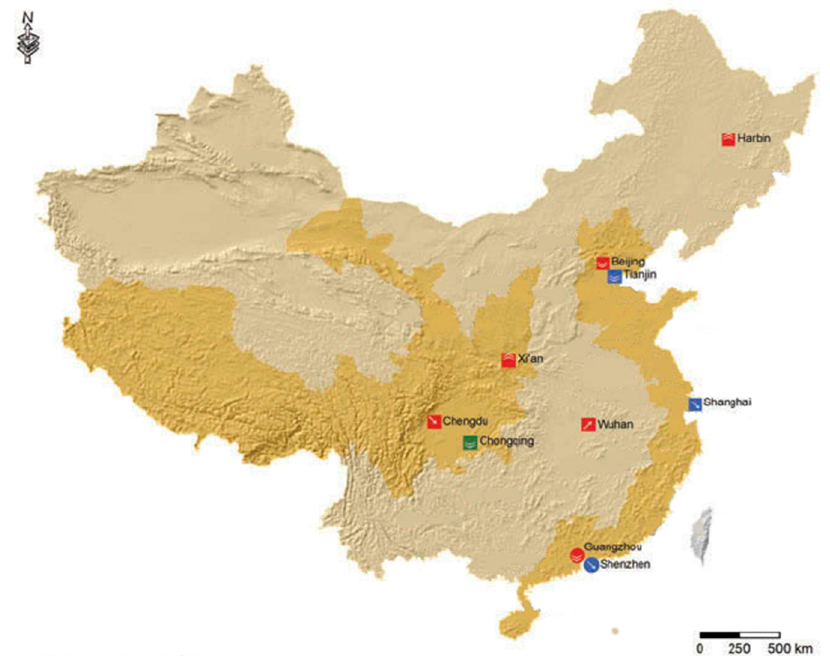
Figure 1. Map of China displaying the 10 mega-cities observed in the study. The map was adopted from Zhou et al. “Effects of spatial form on urban commute for major cities in China,” and modified for use in this publication [14].